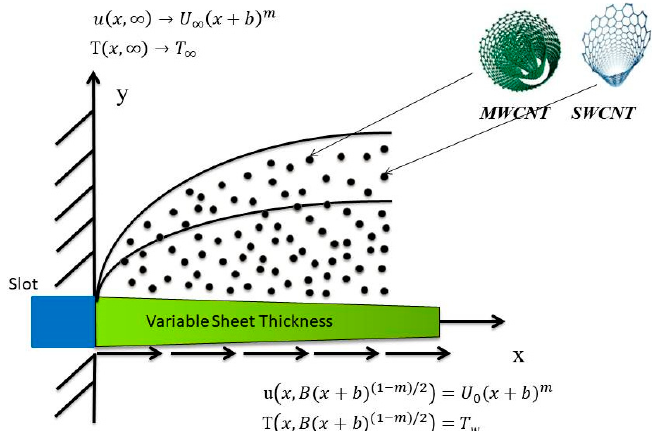
Figure 1. Physical flow model. MWCNT, multi-walled carbon nanotube; SWCNT, single-walled carbon nanotube.